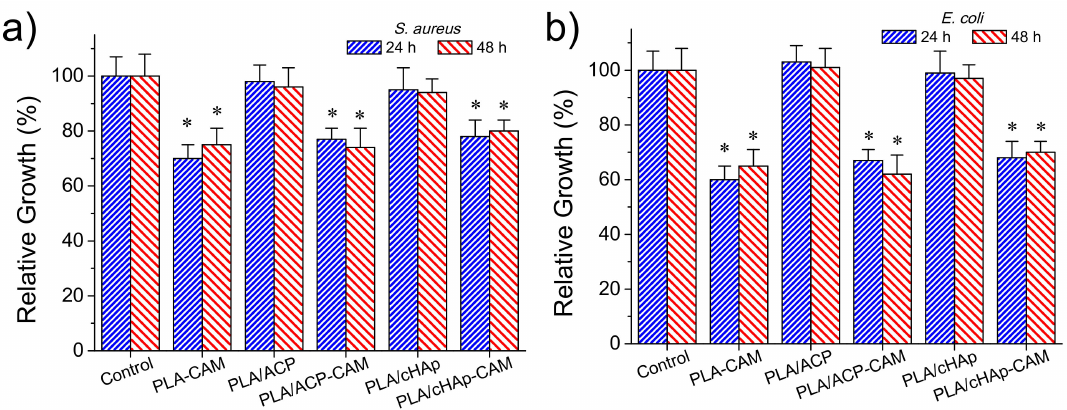
Figure 12. Relative growth of E. coli ( a ) and S. aureus ( b ) bacteria in the control and the indicated PLA sca ff olds, * p < 0.05 vs.